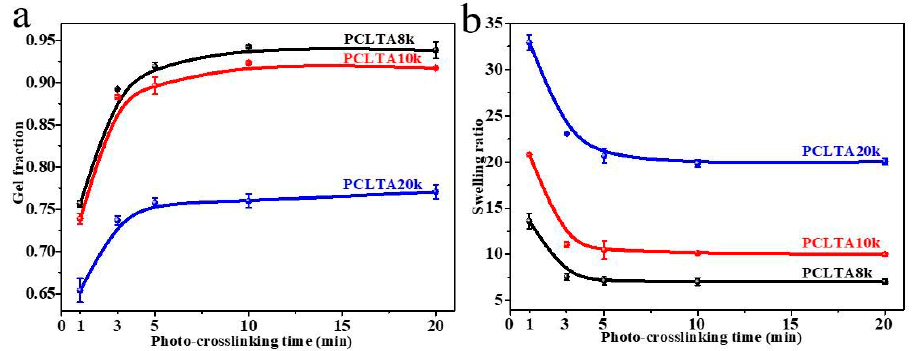
Figure 1. Gel fractions ( a ) and swelling ratios ( b ) of PCLTAs with di ff erent crosslinking time.